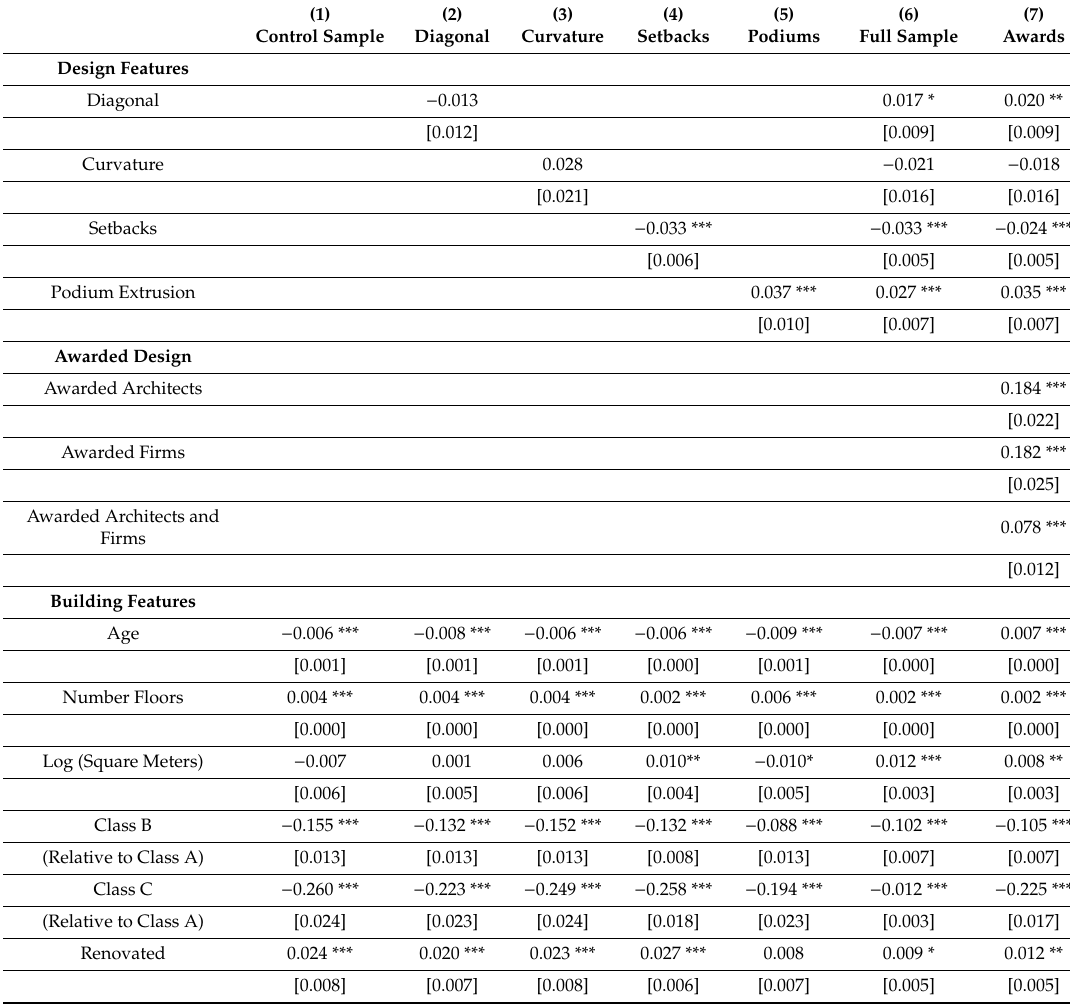
Table 3. Net e ff ective rent per square meter of buildings with architectural design features